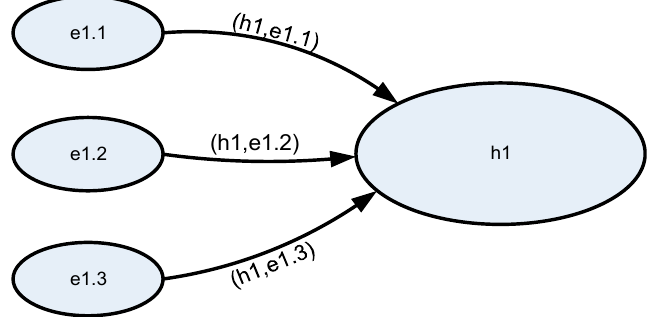
Figure 5. Model for intermediate hypothesis h1.